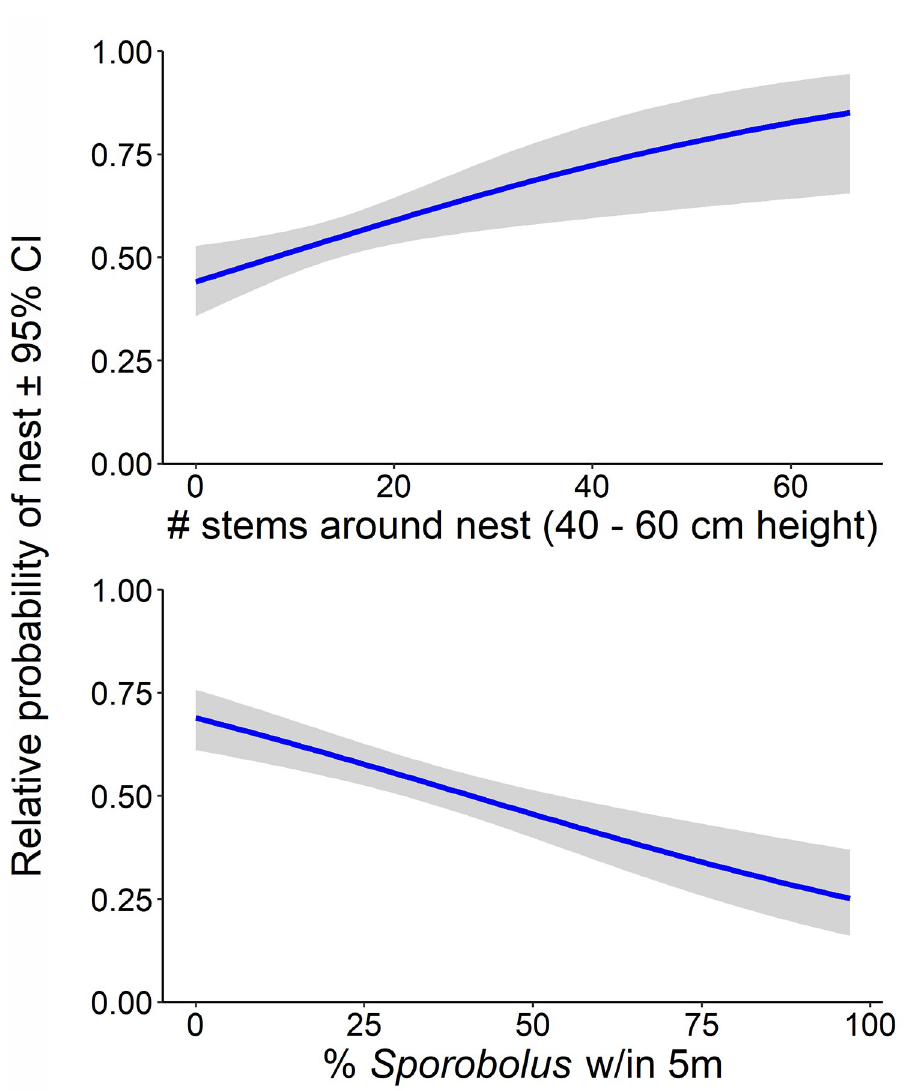
Fig 2. Relative probability ( ± 95% confidence intervals) of a vegetation sampling point being a Seaside Sparrow nest (vs a random point) considering two vegetation variables in Louisiana, 2012–2017. Relative to random locations within a territory, Seaside Sparrows were more likely to place their nests in sites with higher stem densities at mean nest height (~ 40 cm), and with less Sporobolus around the nest. Predicted estimates are derived from the full linear model, setting all other variables to their means, and Bay =